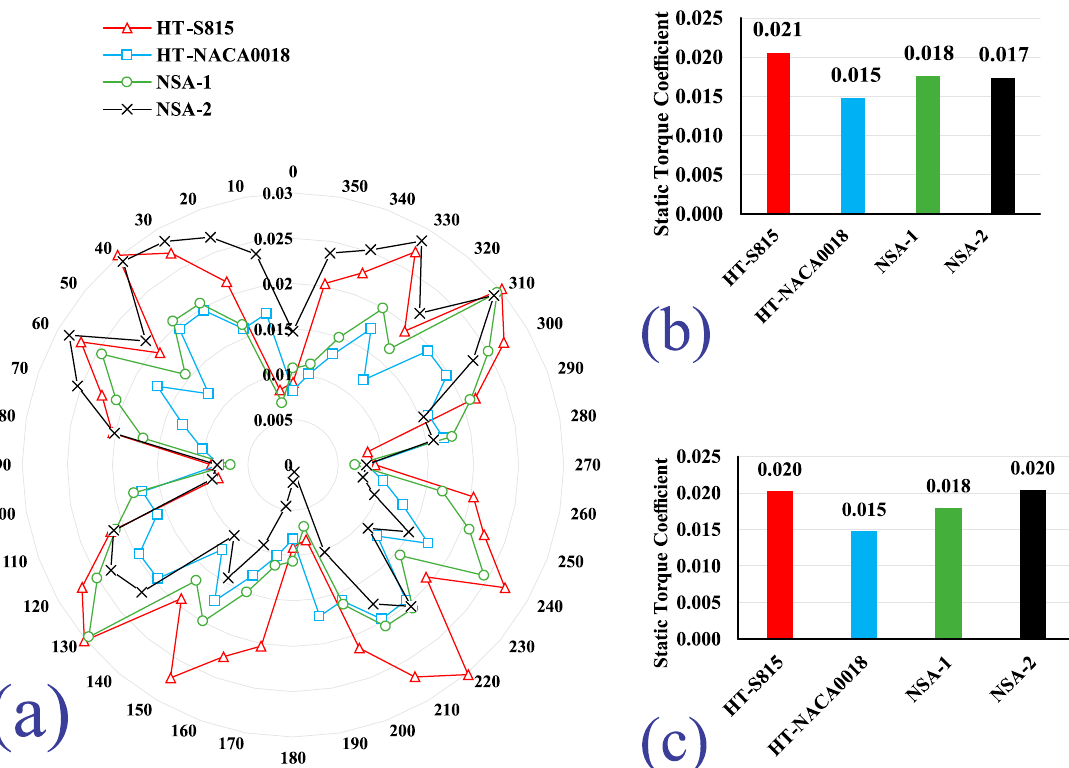
Figure 10. Static torque coefficient: ( a ) one cycle, for zero rotational angle ( Δθ = 0°), see Figure 1, ( b ) the averaged value for one cycle, ( c ) the averaged value for one cycle except for 140° to 260°.